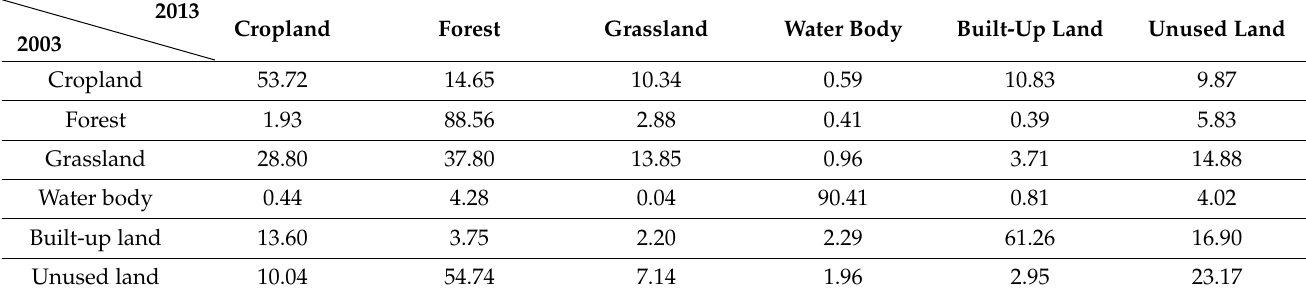
Table 5. Transition matrix of different land-use types from 2003 to 2013